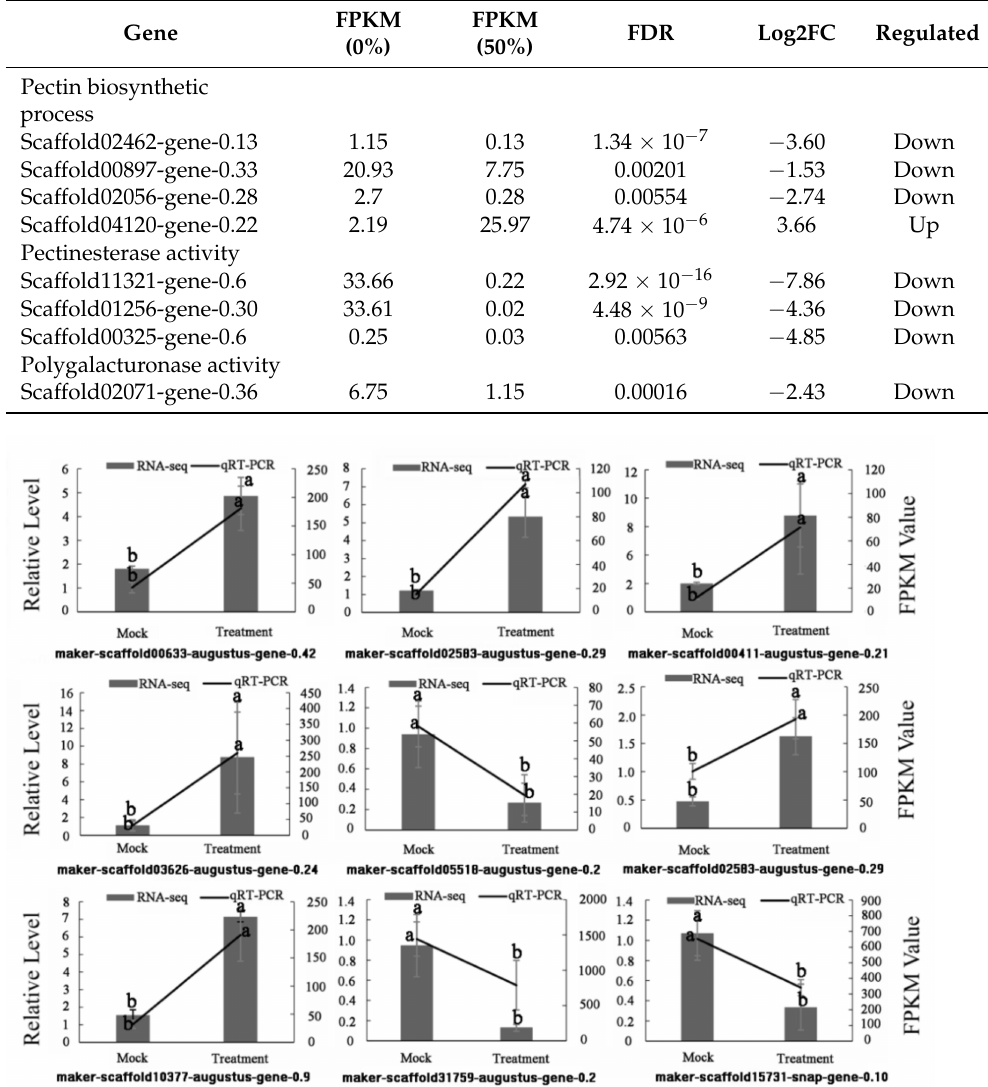
Table 4. Genes involved in pectin metabolism.